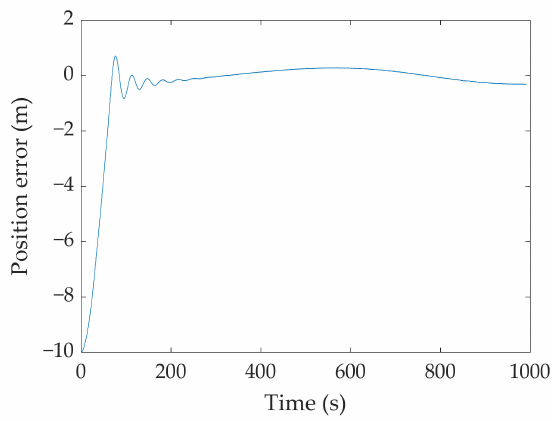
Figure 13. Position error for the circle path